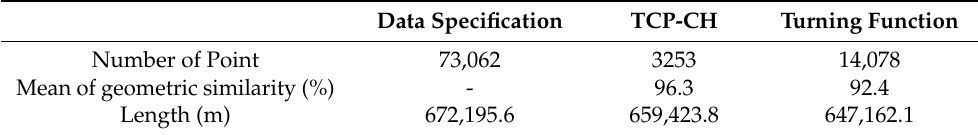
Table 4. Comparison of results between proposed trajectory critical point detection using convex hull (TCP-CH) method and turning function method in detecting geometric critical points.